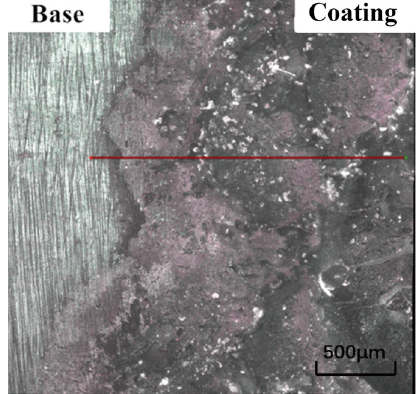
Figure 12. Surface profile measurement.